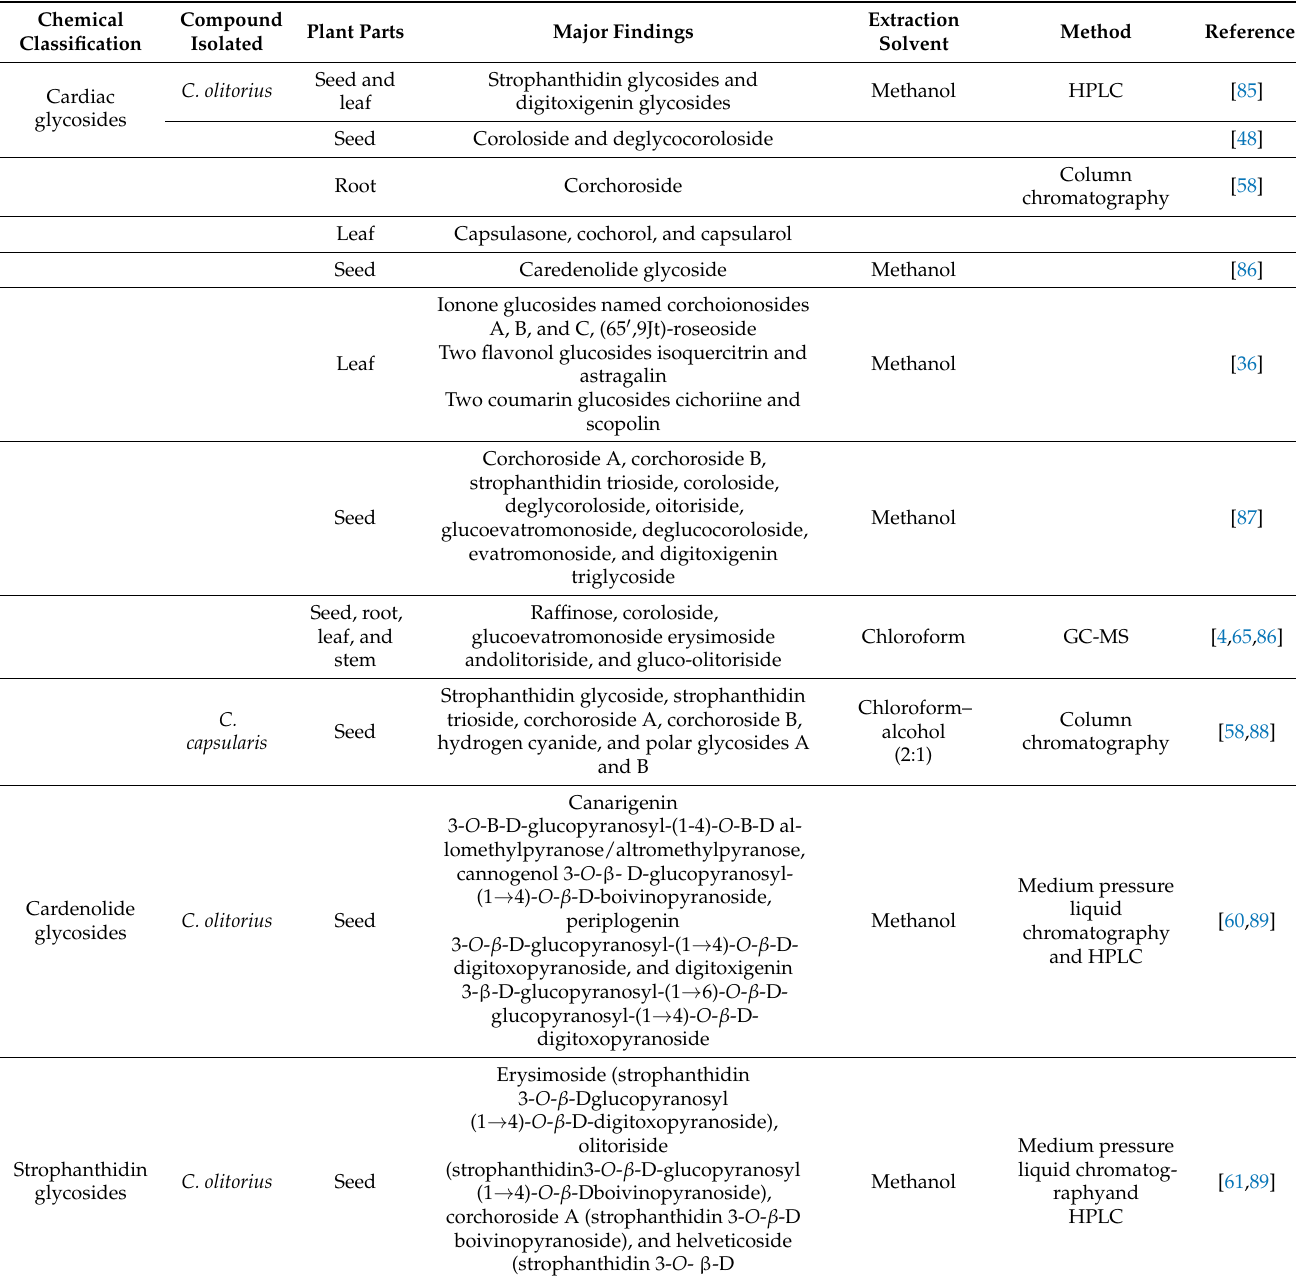
Table 3. Chemicals isolated from different parts of C. capsularis and C. olitorius